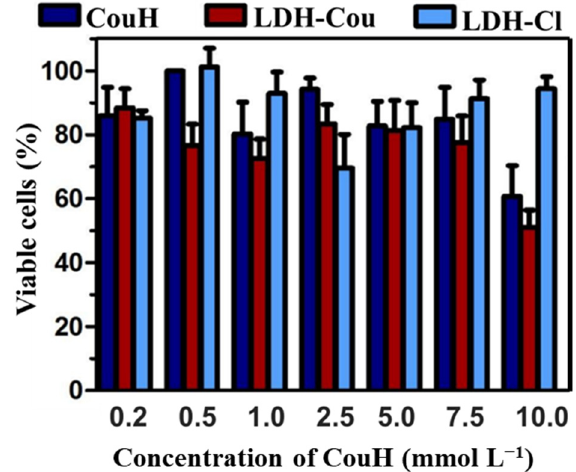
Figure 4. Viable cell percentage. Results extracted post-treatment with different concentration of CouH, LDH-Cou, and LDH-Cl (as reported in Section 2.3.2), evaluated by neutral red incorporation, average ± SD ( n = 6).